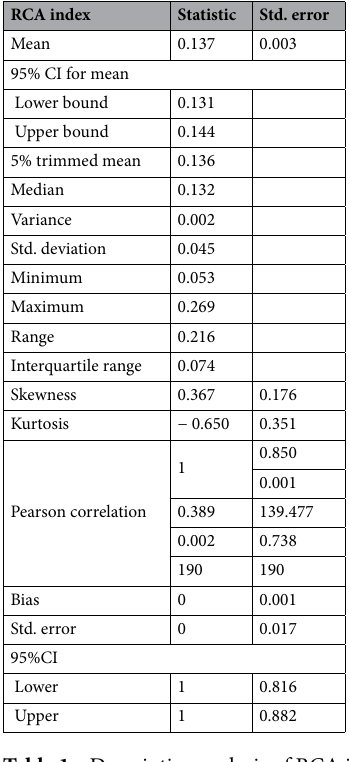
Table 1. Descriptive analysis of RCA index in the Control group.